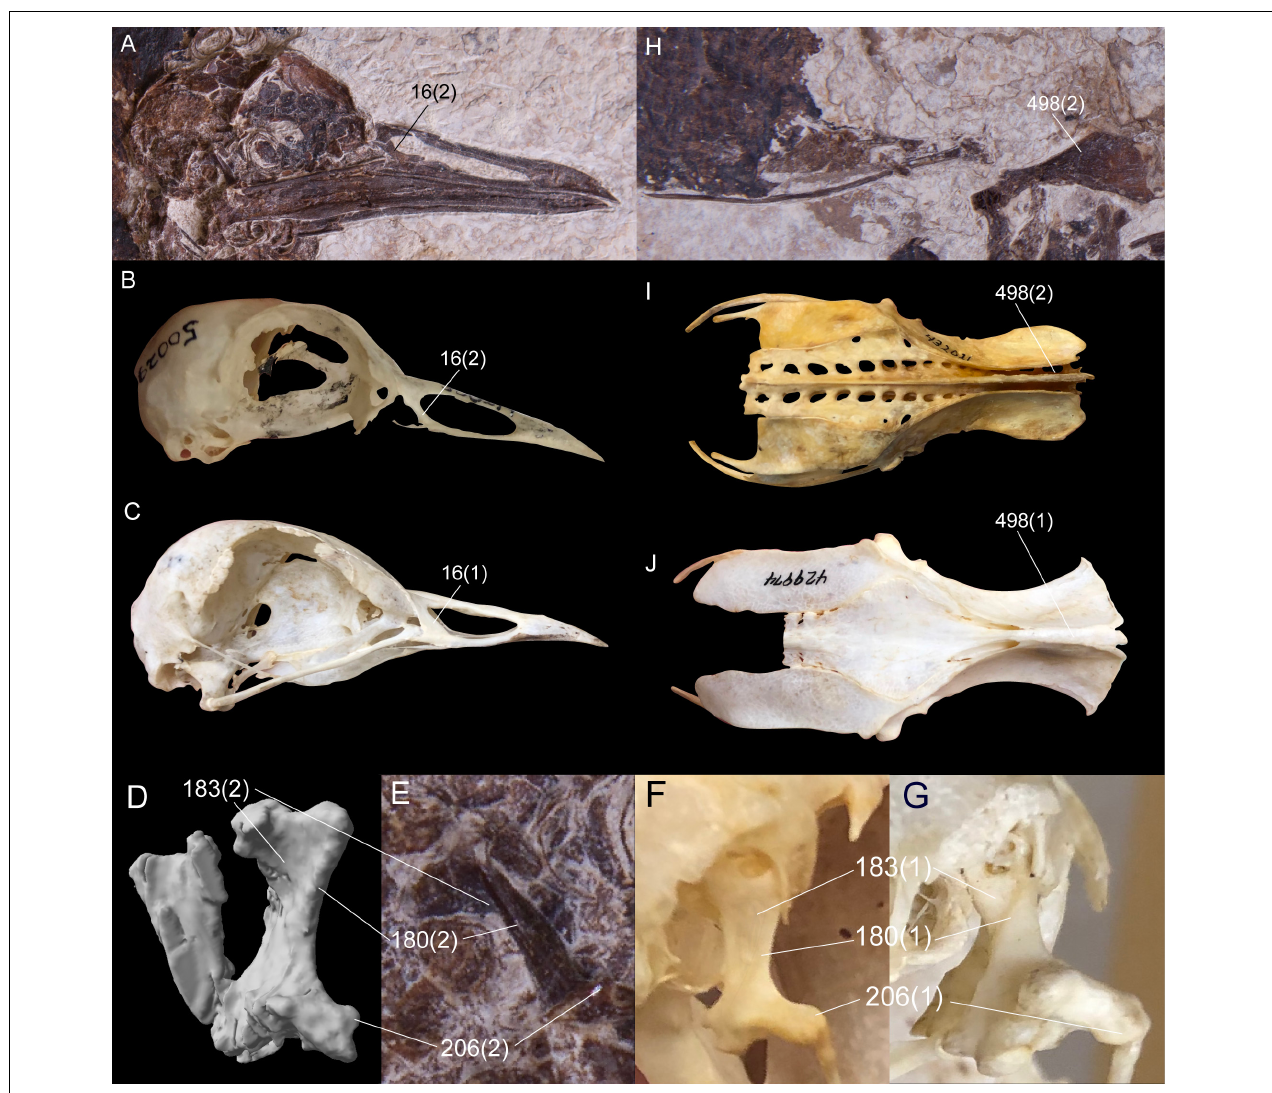
FIGURE 6 | Comparison of selected optimized synapomorphies that place Nahmavis grandei within Charadriiformes to the exclusion of Gruiformes under the Kimball et al. (2019) backbone constraints. Synapomorphies are shown with the character number followed by the state in parentheses. (A–C) Skulls of N. grandei , Pluvianus aegyptius , and Psophia crepitans . (D,E) segmented CT image and photograph of the right quadrate of N. grandei . (F,G) right quadrates of Vanellus coronatus and P. crepitans . (H–J) pelvises of N. grandei , Burhinus bistriatus and P. crepitans